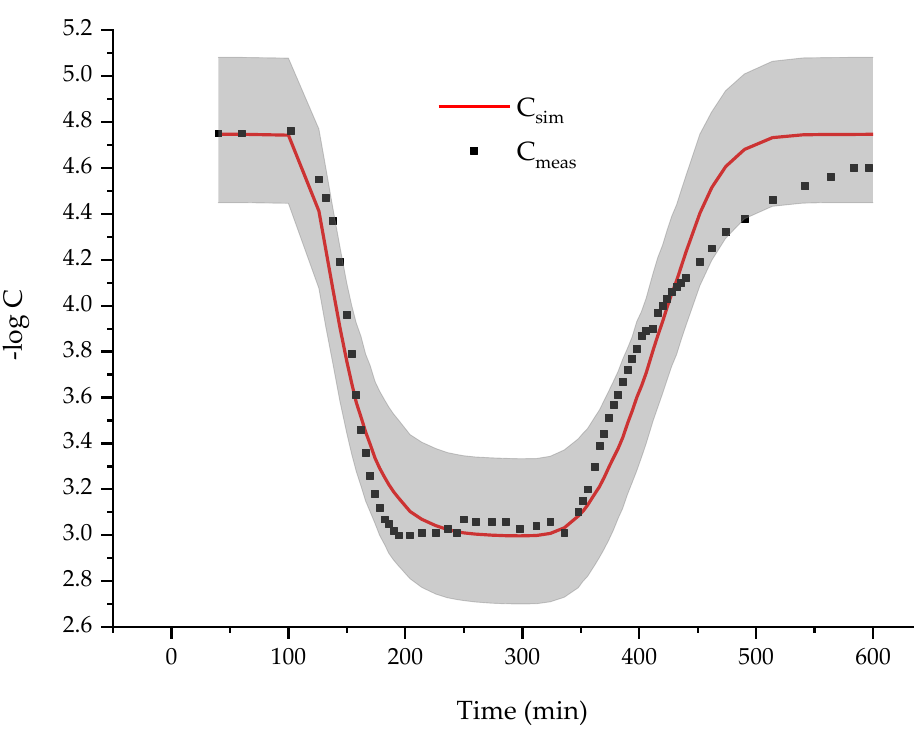
Figure 3. Observed (symbols), calibrated (lines), and predictive uncertainty (grey band) for the effluent bromide concentration using the linear transport model.